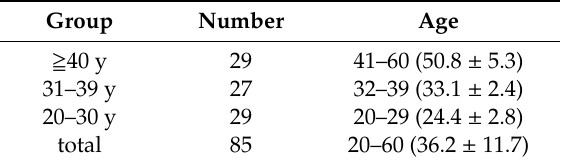
Table 2. Age classification of the